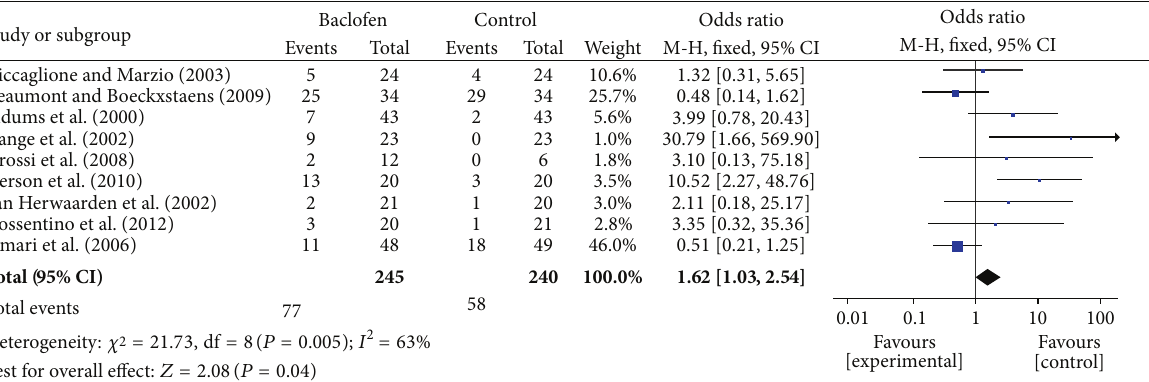
Figure 4: Meta-analysis of the incidence of TLESR in the PP population given either baclofen or placebo for the treatment of GERD.